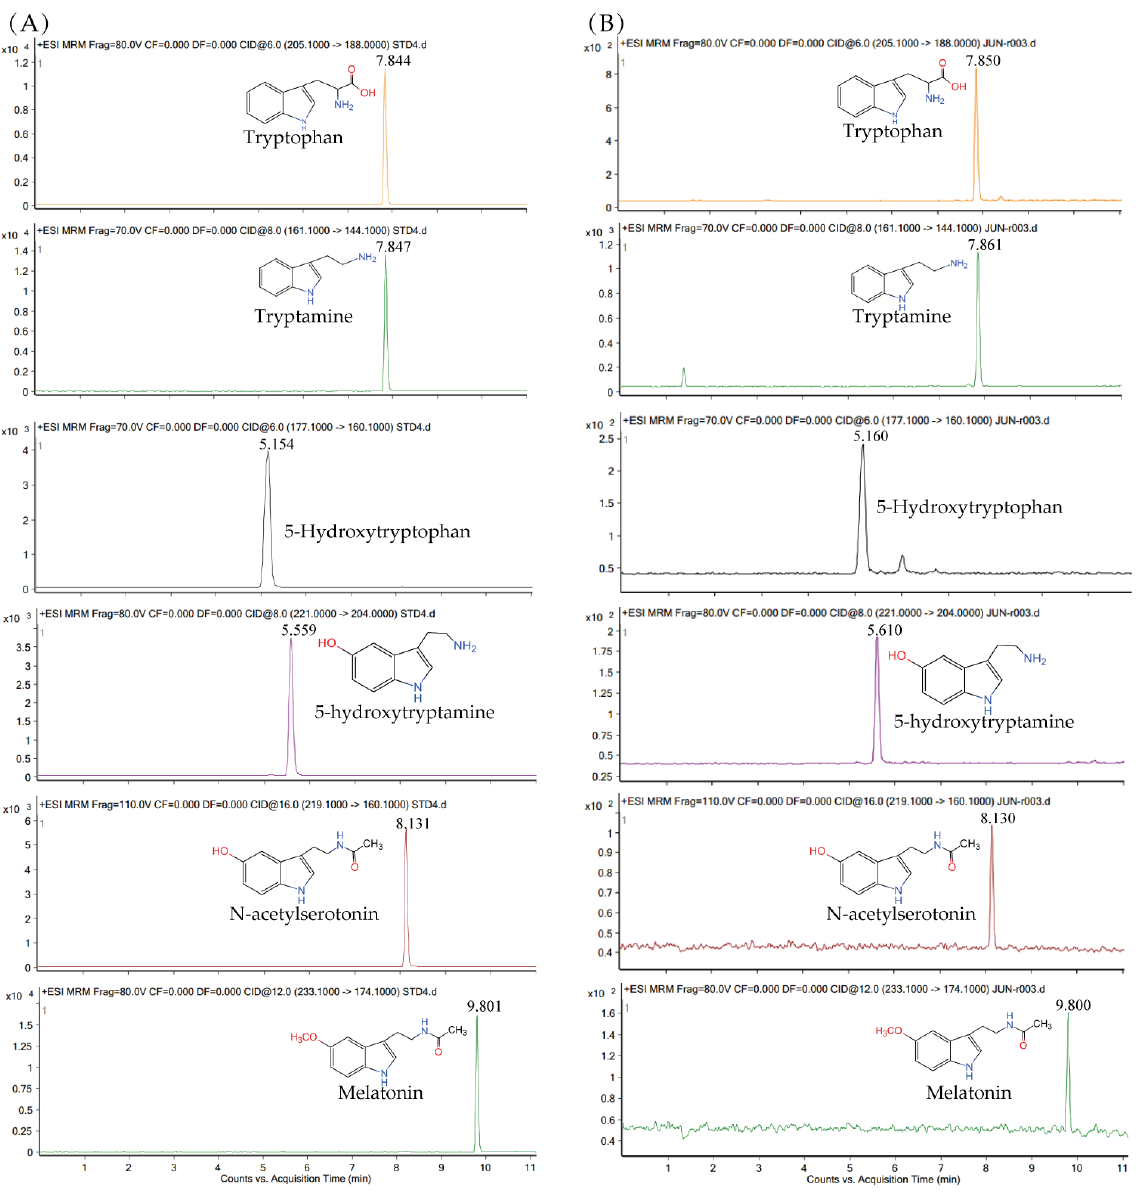
Figure 2. Detection of MT biosynthetic intermediates in Xoo . ( A ) Chemical structures and chroma ‐ tograms of tryptophan, tryptamine, 5 ‐ hydroxytryptophan, 5 ‐ hydroxytryptamine, N ‐ acetylserotonin and MT standards. ( B ) Chromatograms of tryptophan, tryptamine, 5 ‐ hydroxytryptamine, N ‐ acetyl ‐ serotonin and MT in Xoo cells. Xoo cells were harvested after 24 h and the metabolites were extracted with ethyl acetate. The dried samples were reconstituted in 200 μ L methanol and analyzed by LC ‐ MS/MS.